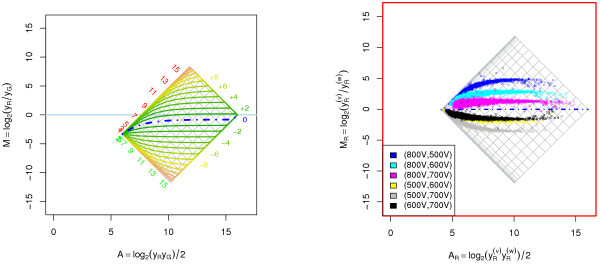
Affine transformation of the red and the green signals. Left: Affine transformation of the red and the green signals for A1
MathType@MTEF@5@5@+=feaafiart1ev1aaatCvAUfeBSjuyZL2yd9gzLbvyNv2CaerbwvMCKfMBHbqedmvETj2BSbWenfgDOvwBHrxAJfwnHbqeg0uy0HwzTfgDPnwy1aqee0evGueE0jxyaibaieYdOi=BH8vipeYdI8qiW7rqqrFfpeea0xe9Lq=Jc9vqaqpepm0xbbG8FasPYRqj0=yi0lXdbba9pGe9qqFf0dXdHuk9fr=xfr=xfrpiWZqaaeaabiGaaiaacaqabeaadaqacqaaaOqaaGWaaiab=bq8bnaaBaaaleaatCvAUfKttLearCWrP9MDH5MBPbIqV92AaGqbaiab+fdaXaqabaaaaa@43C0@ = {(aG, aR) = (200, 20), (bG, bR) = (1.4, 0.8)}. The observed log-ratios as a function of the observed log-intensities for different fold changes. The blue dot-dash curve corresponds to the non-differentially expressed genes and the thinner curves above and below this curve represent log2r = ± 1, ± 2,... as labeled to the right of the curves. The lines in the gray grid, which is rotated 45 degrees (in (2A, M)), show the levels where the true signals log2 xR and log2 xG are equal to ..., -1, 0, 1,..., 16. These levels have been labeled to the left of the grid. No observations can lie outside this grid. Right: Real-world example of an affine transformation. The same slide was scanned four times at four different PMT settings. For each of the six scan pairs, the within-channel log-ratio and log-intensities were calculated. Data shown is from the red channel, which was estimated to have an offset of aR = 20.3 for all scans.